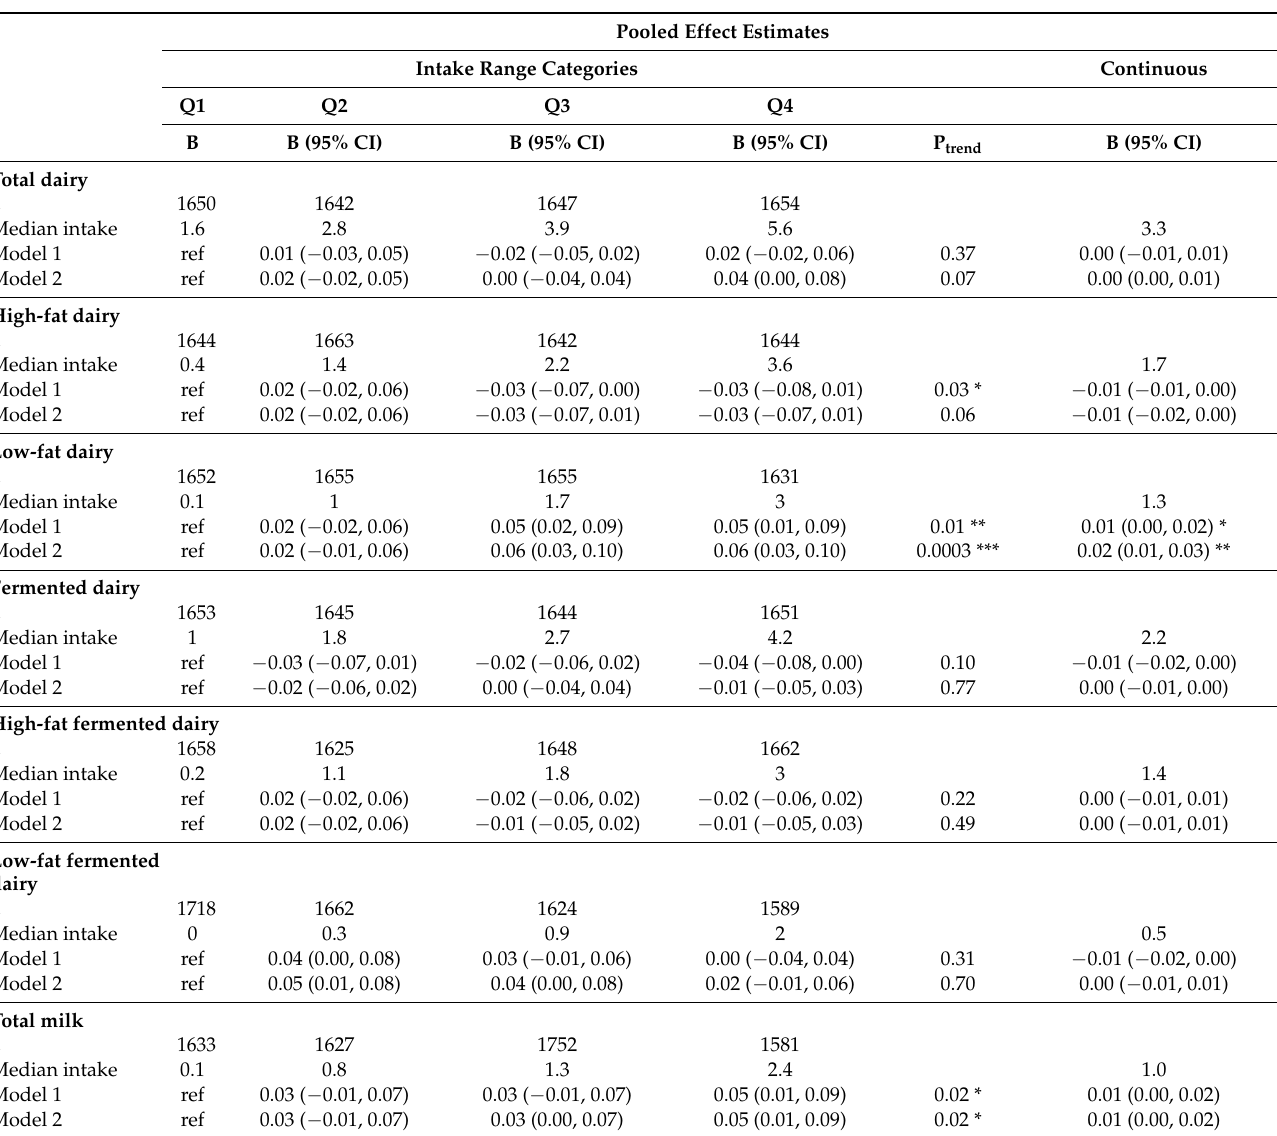
Table 3. Associations of dairy product types and longitudinal insulin resistance in the Rotterdam Studies ( n =